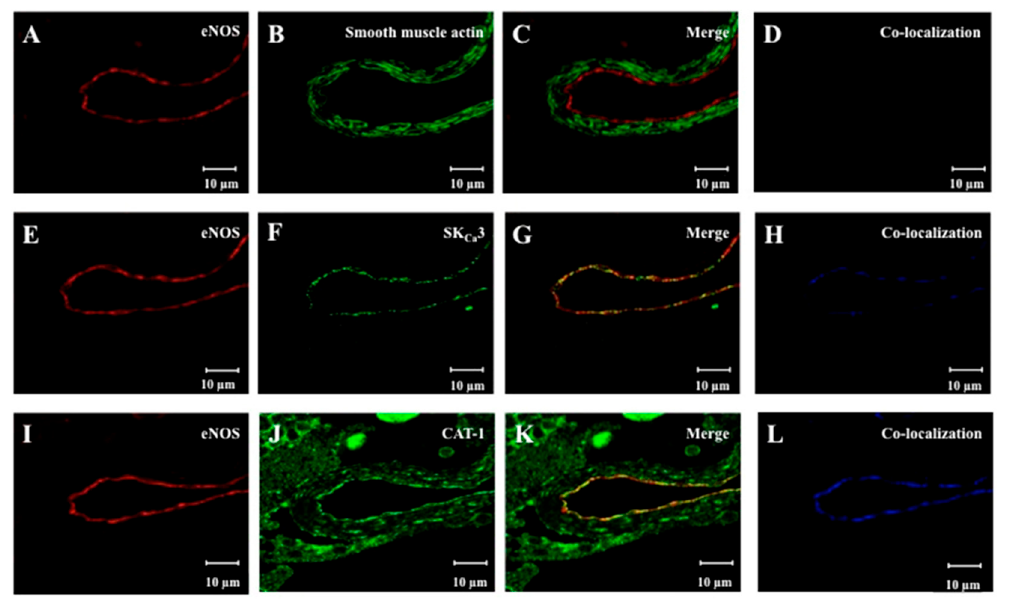
Figure 2. Representative images showing immunoreaction for ( A ) eNOS, ( B ) smooth muscle actin, and ( C ) merged immunoreaction for eNOS and smooth muscle actin, and ( D ) no co-localization of eNOS and smooth muscle actin. Immunoreaction for ( E ) eNOS, ( F ) SKCa3, and ( G ) merged immunoreaction for eNOS and SKCa3, and ( H ) co-localization in blue of eNOS and SKCa3. Immunoreaction for ( I ) eNOS, ( J ) CAT-1, and ( K ) merged immunoreaction for eNOS and CAT-1, and ( L ) co-localization in blue of eNOS and